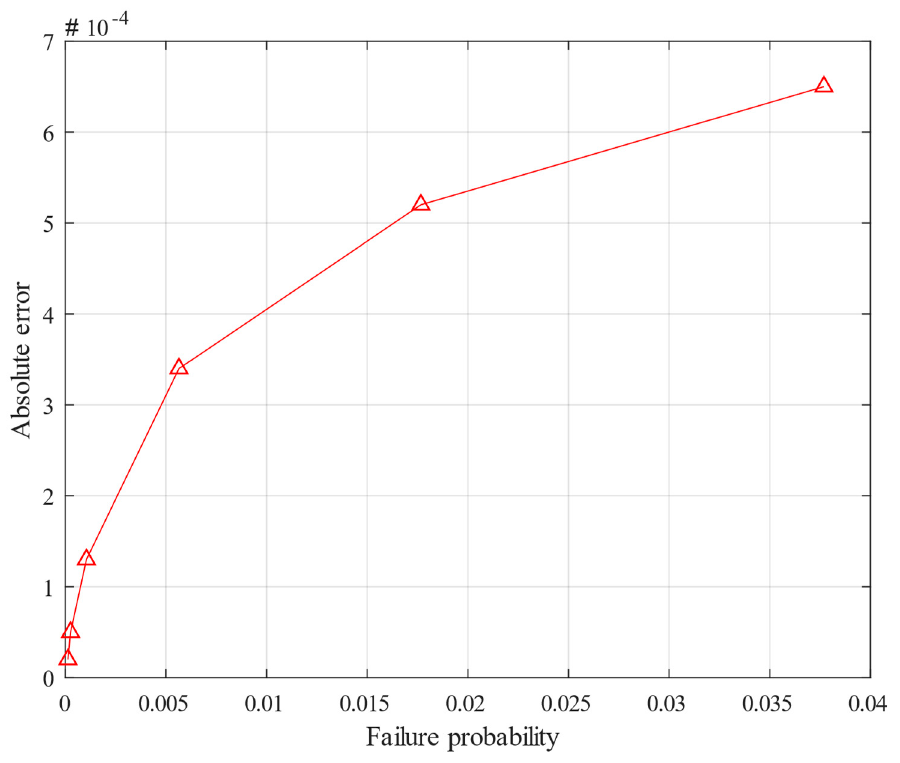
Figure 8. Absolute error vs. failure probability.